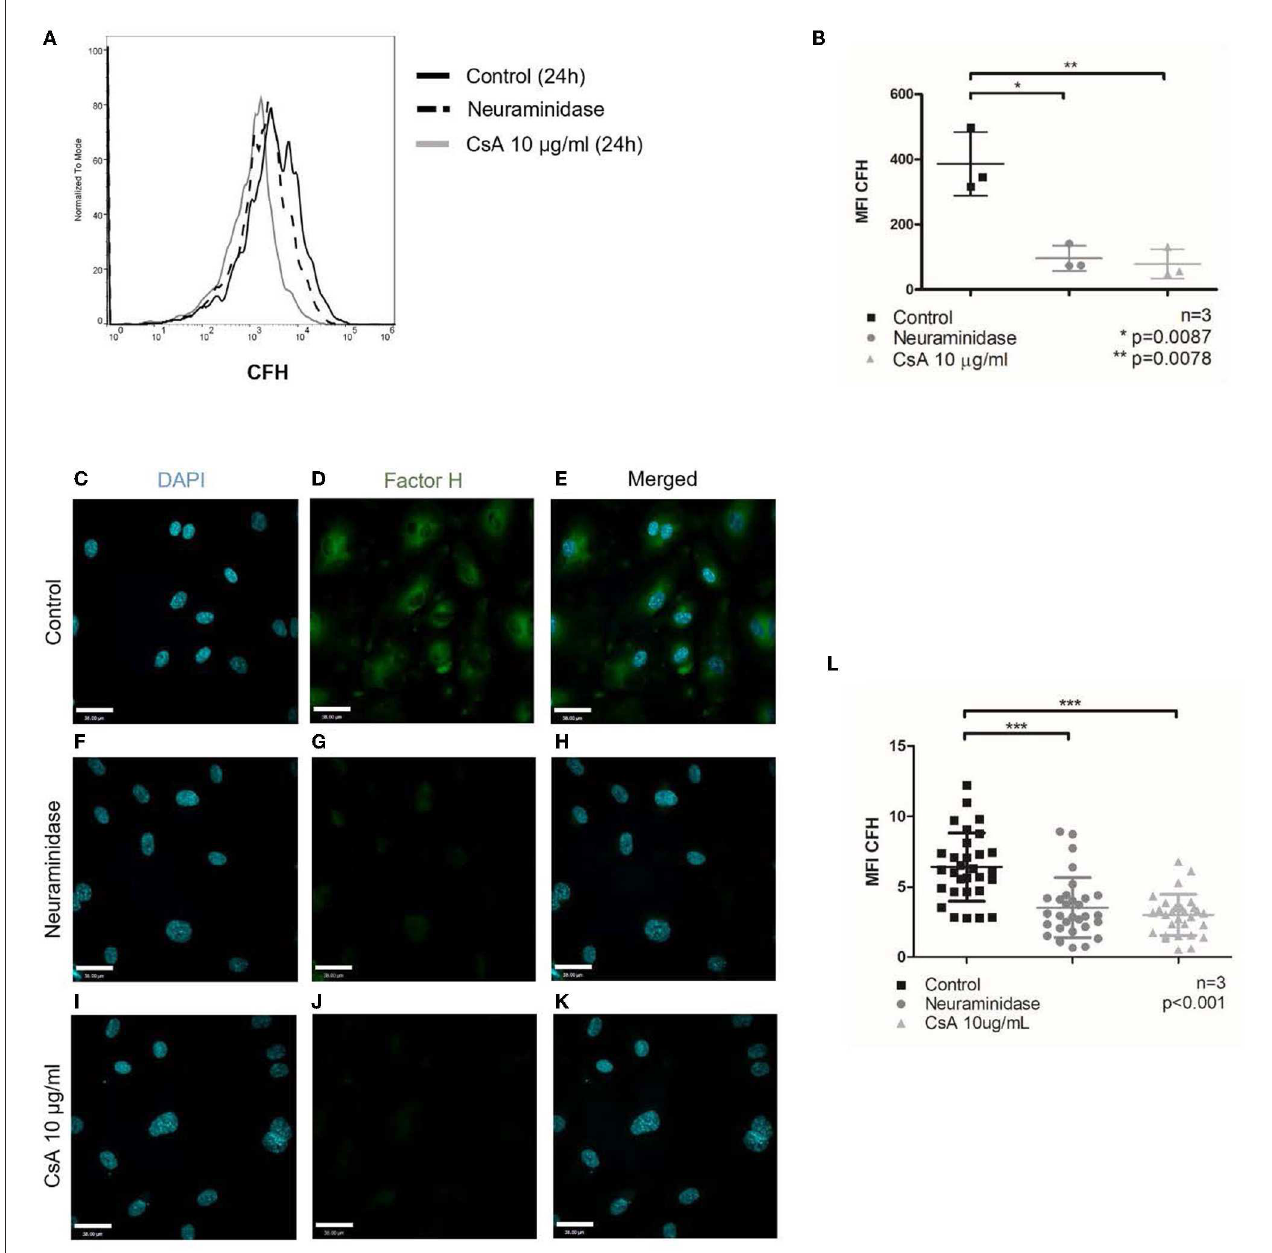
FIGURE4 Cyclosporine causes reduced complement factor H binding on surfaces of endothelial cells. Alexa Fluor 488-conjugated complement factor H (CFH) binding on blood outgrowth endothelial cell (BOEC) surface was assessed by flow cytometry (A, B) . Non-viable cells were excluded from analysis